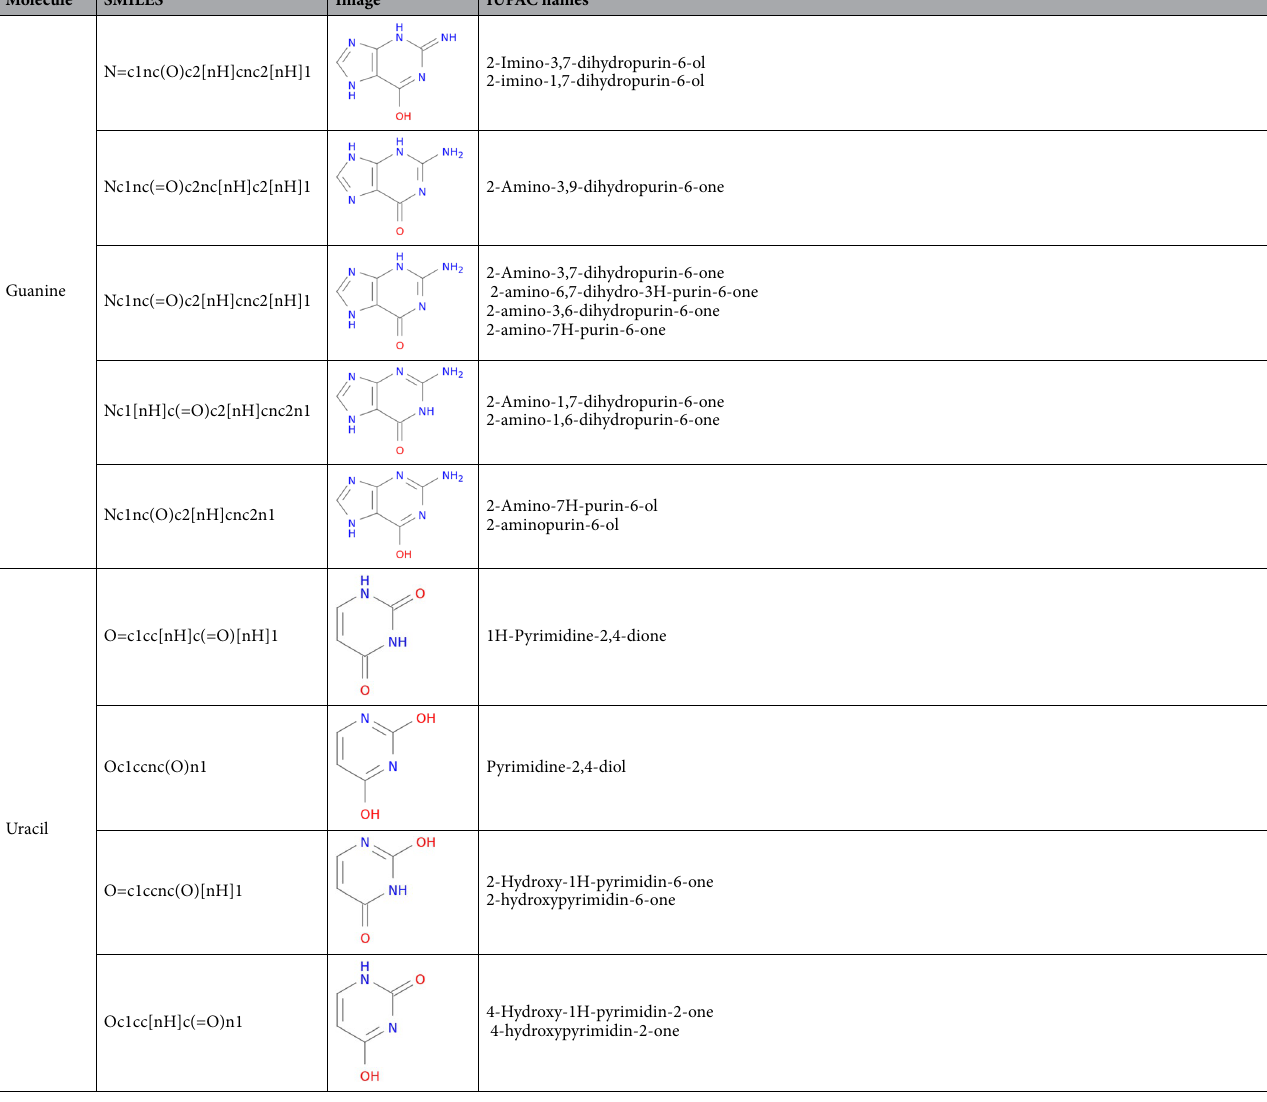
Table 2. The generated IUPAC names for various tautameric forms of Guanine and Uracil.